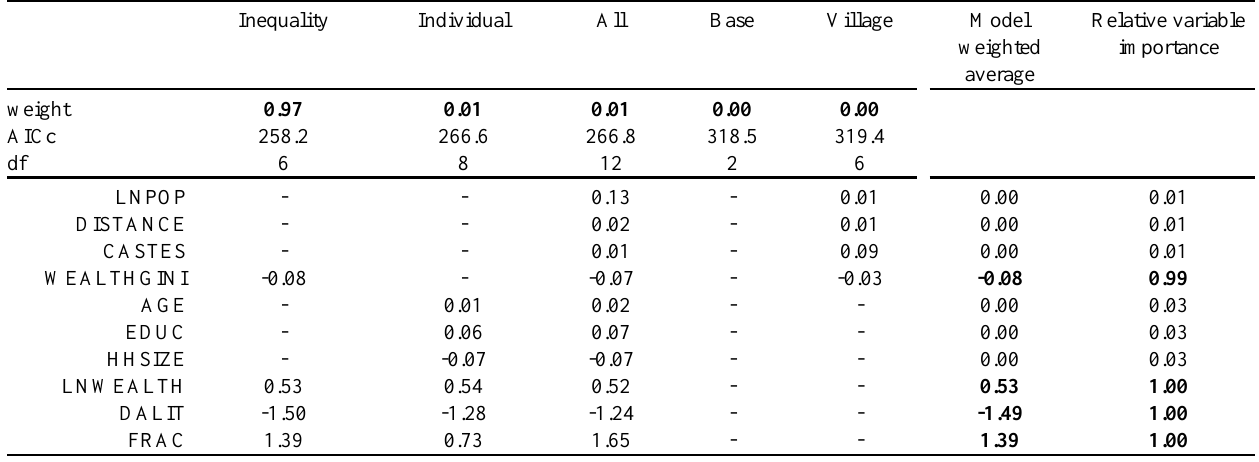
Table 6. AICc multimodel selection results. Akaike weights and coefficients for five logistic regression models predicting CHANNEL distribution. The last two columns on the right provide model weighted average coefficients and relative variable importance measures for each variable (Burnham and Anderson 2002). The inequality model captured the largest Aikaike weight, and best explains the distribution of irrigation channels. Inequality Individual All Base Village Model Relative variable weighted importance average weight 0.97 0.01 0.01 0.00 0.00 AICc 258.2 266.6 266.8 318.5 319.4 12 6 0.01 DISTANCE